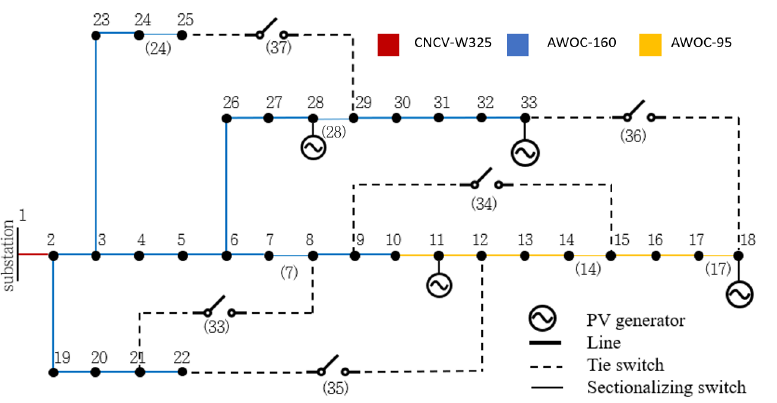
Figure 3. Modified 33-bus distribution test feeder. There are two solar PV generators at buses 18 and 33; five sectionalizing switches (7), (14), (17), (24), and (28); and five tie switches (33), (34), (35), (36), and (37).